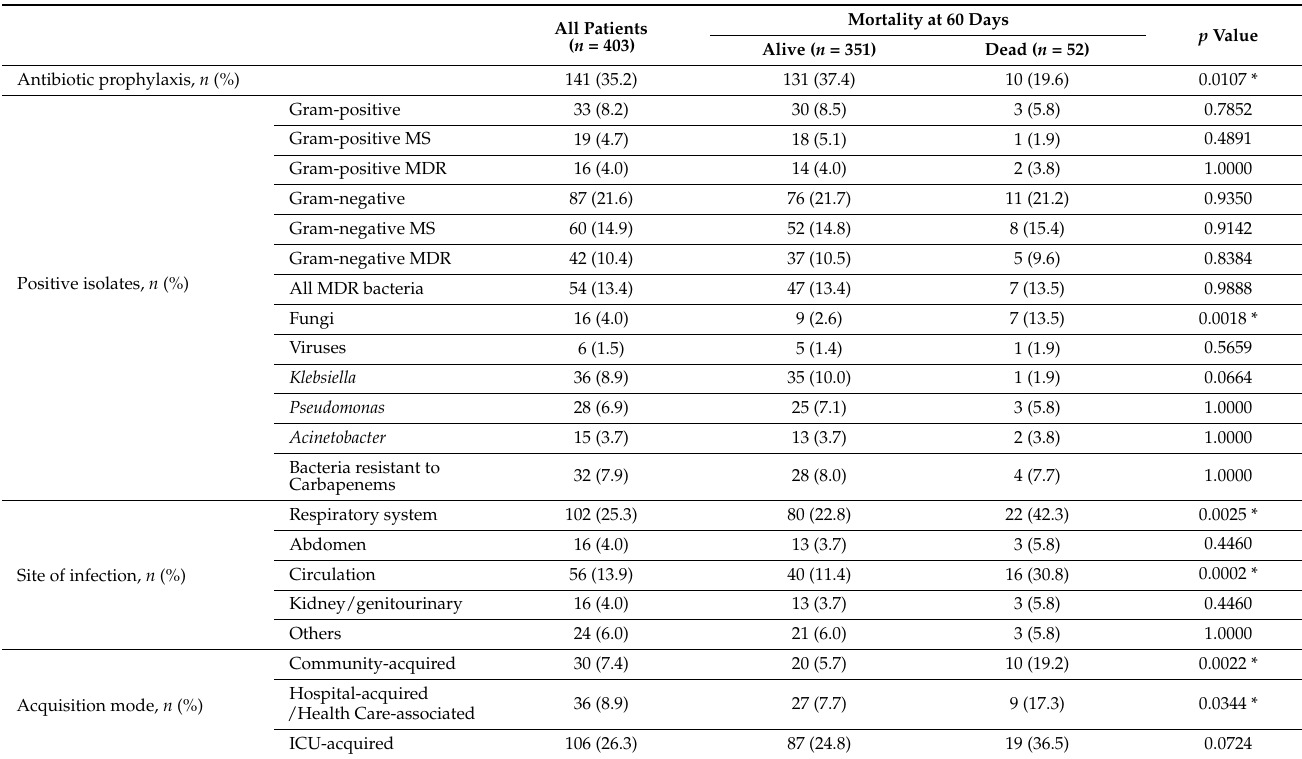
Table 3. Infection characteristics according to mortality (note: total number of patients is 403, as 32 patients’ outcome data were